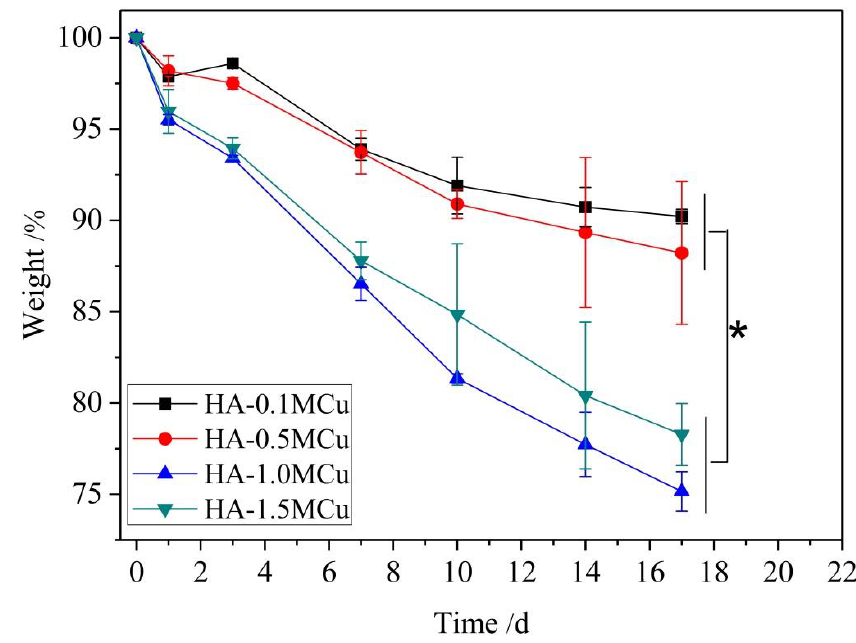
Figure 7. Weight loss rate of sintered Cu-doped HA macrobeads in acidic SBF (pH = 3). (* p < 0.05).